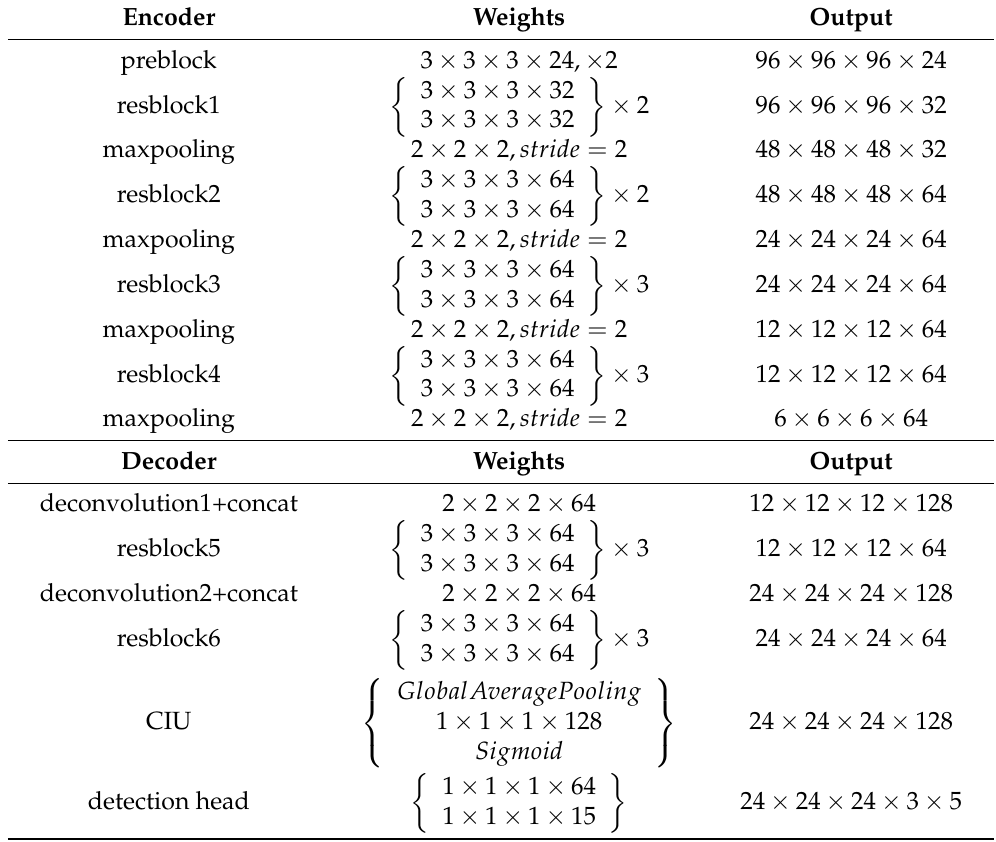
Table 1. Detailed network structure for